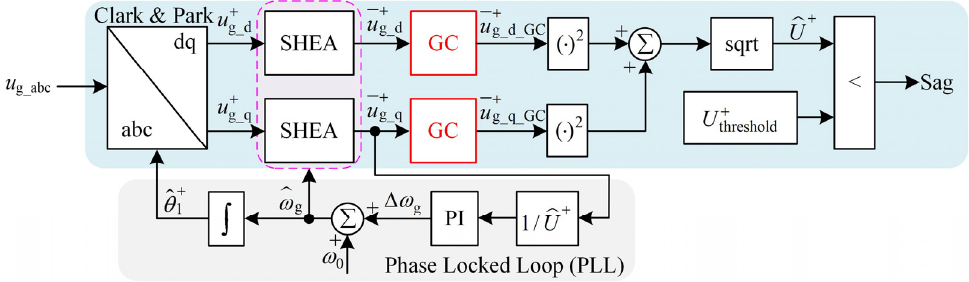
Figure 8. The proposed voltage sag detection method based on SHEA.